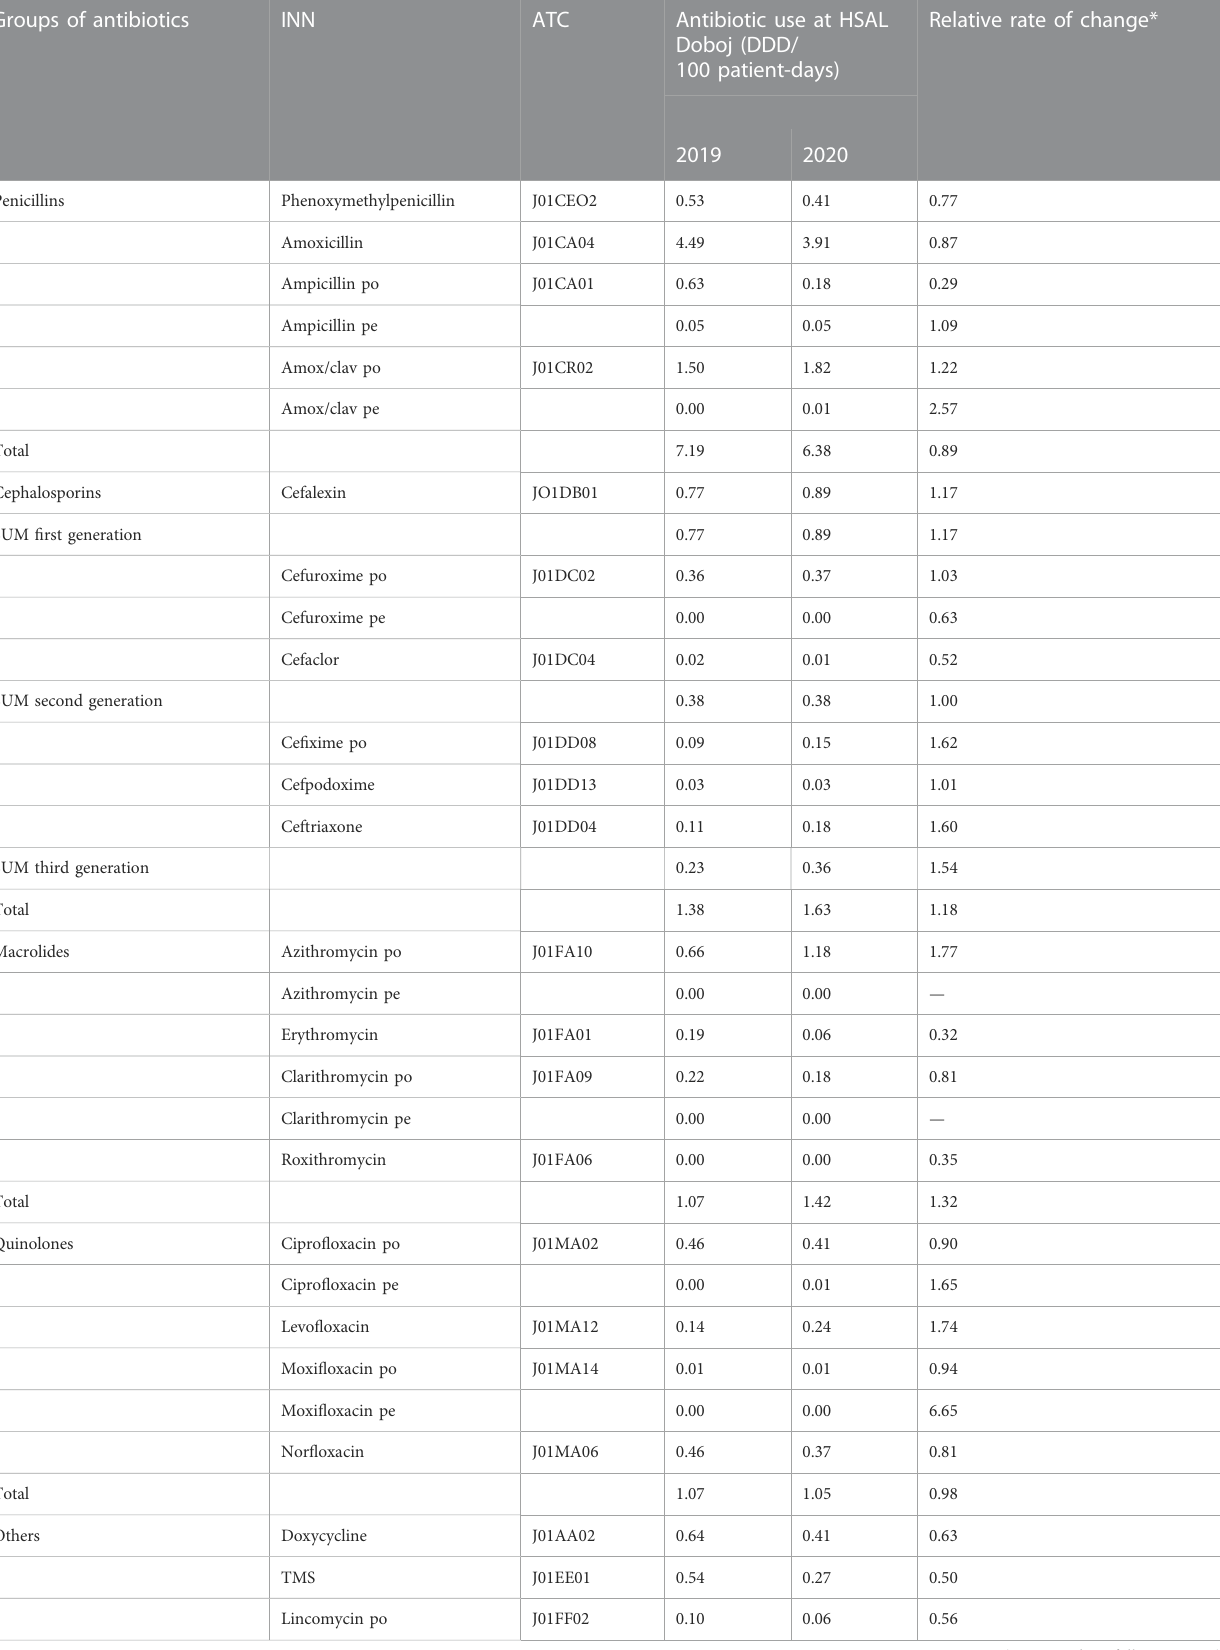
TABLE7De fi neddailydoseper1,000inhabitantsperdayofantibioticsforsystemicintheoutpatientsettingbefore(2019)andduringthepandemicperiod(2020) in HSAL Doboj Region per year. Groups of